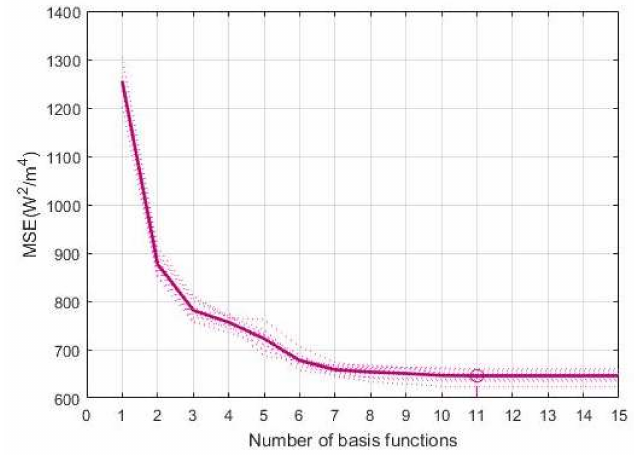
Figure 2. Determination of the optimum number of basis functions. Mean square error